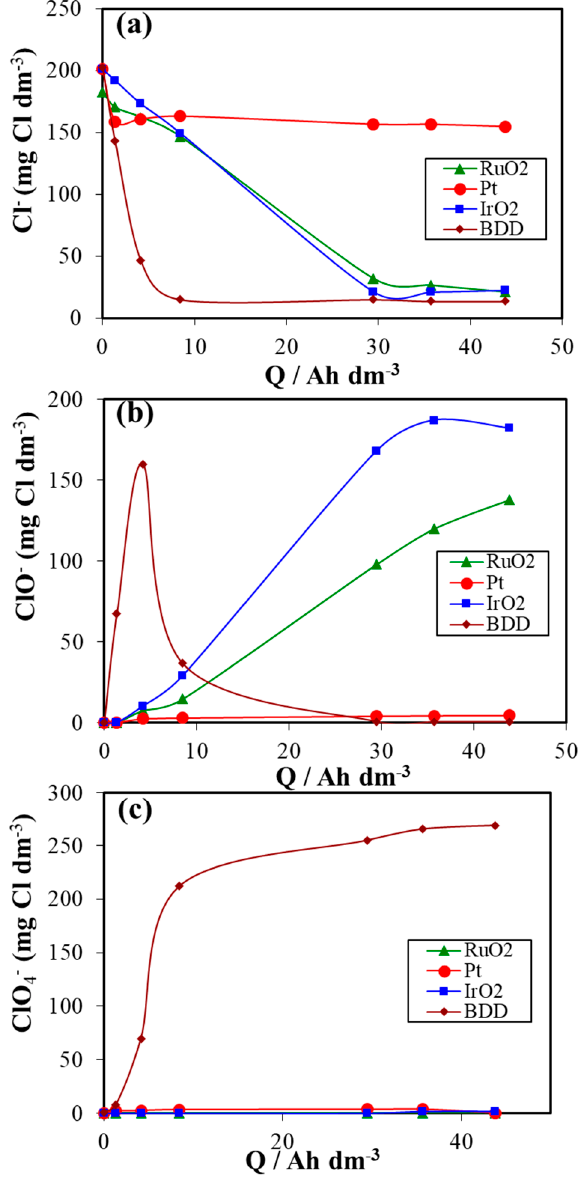
Figure 7. Speciation of chlorine during the electrochemical treatment of urine wastewaters with different anode materials. ( a ) Chlorides, ( b ) Hypochlorites, ( c ) Perchlorates